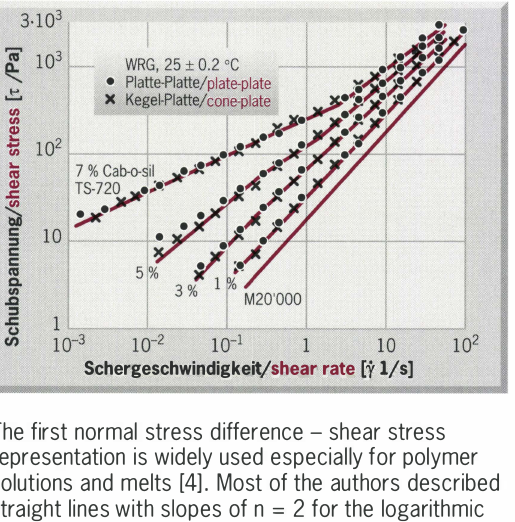
Fig. 1: Rheological